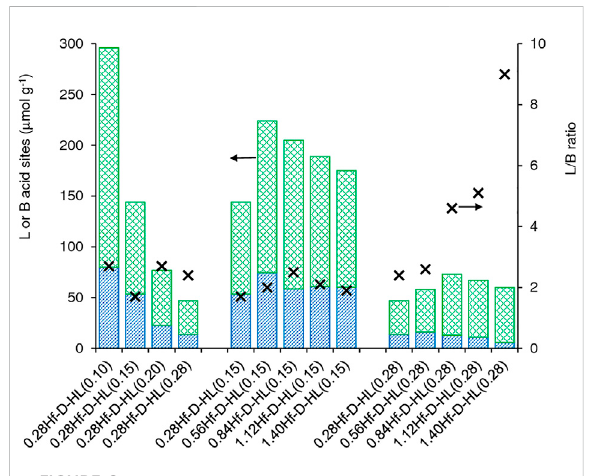
FIGURE 6 Acid properties of the materials prepared from commercial KL via post-synthesis modi fi cations: L = Lewis acid sites (top green bar),B=Brønstedacidsites(bottombluebar)andL/Bratio(×).The values are given in Table